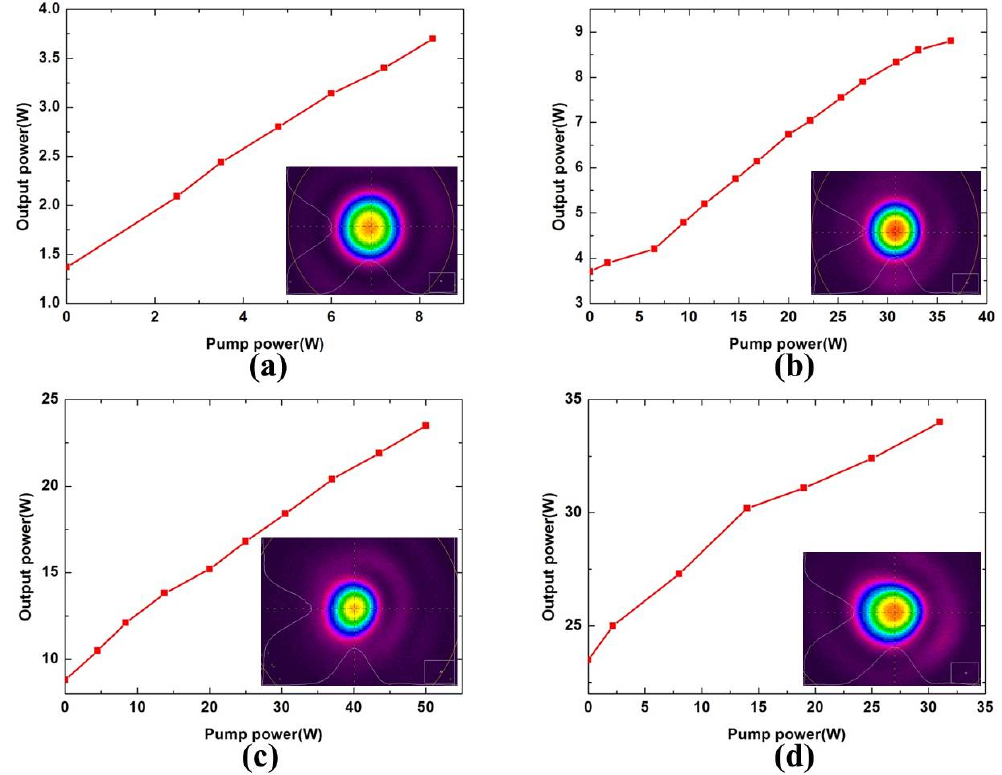
Figure 8. Power curves and beam images of each stage. ( a ) First stage; ( b ) second stage; ( c ) third stage; ( d ) fourth